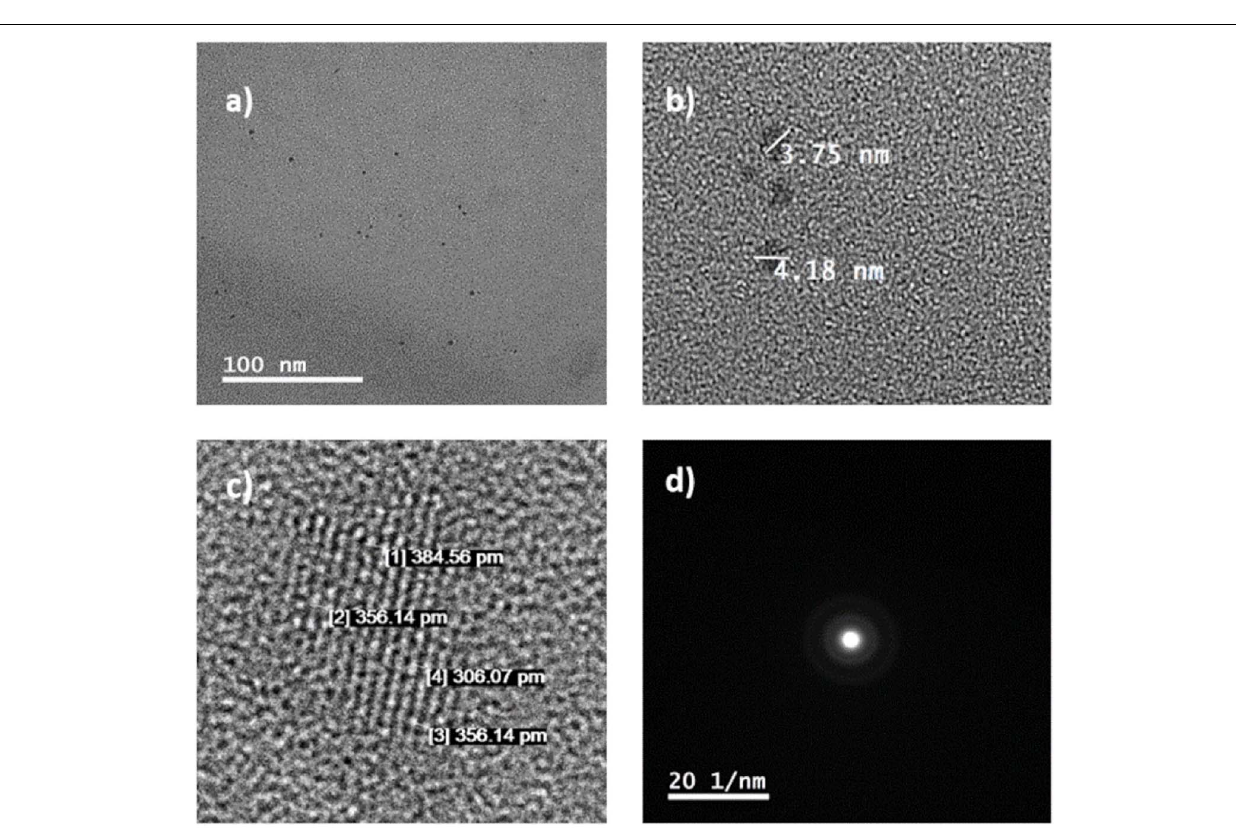
The XRD pattern of C-DOTS ( Figure 3B ) revealed a single broad diffraction peak at 2 θ = 26 ◦ that corresponded to the crystal lattice distance of (0 0 2) ( d 002 = 0.34 nm), and demonstrated a well-ordered lamellar structure with layered regularity (Dang et al., 2016).